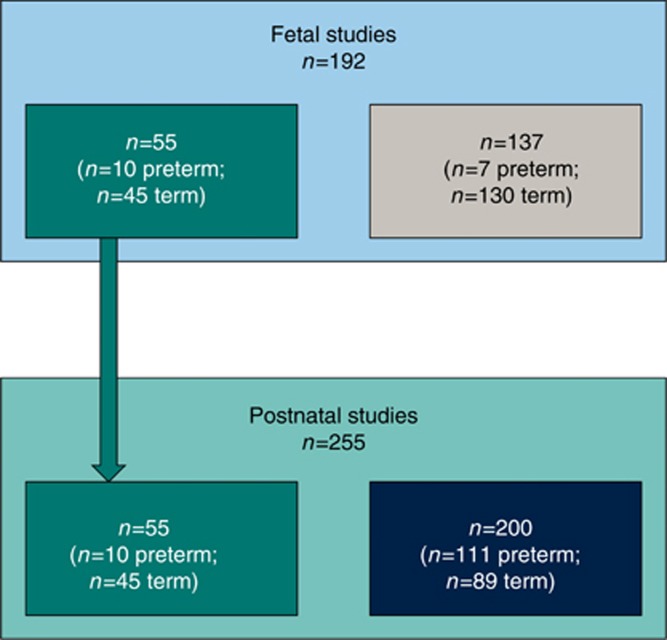
Flow diagram of study recruitment. A total of 392 individuals took part in the study for echocardiography imaging. One hundred and ninety two individuals were recruited during gestation (fetal studies) to undergo echocardiography scans, with n=55 (n=10 preterm; n=45 term, shown in teal) going on to take part in the postnatal studies. An additional n=200 individuals were recruited at birth (shown in dark blue) to take part in birth and 3-month postnatal age echocardiography scans (total n=255 postnatal studies, n=121 preterm; n=134 term).